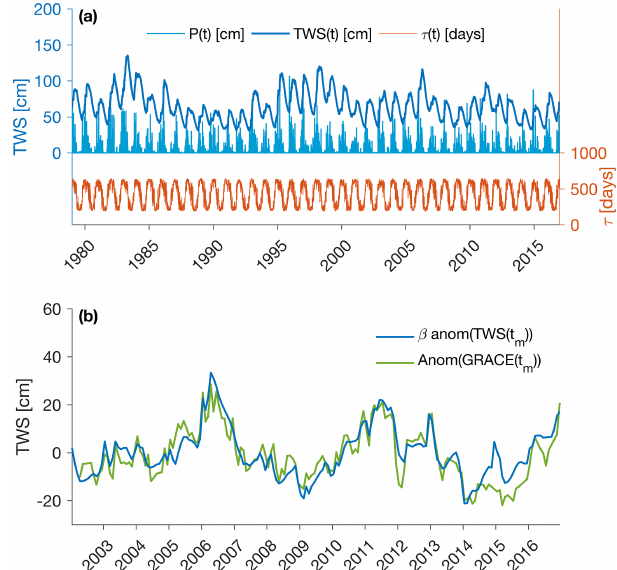
Figure 1. Illustration of the GRACE reconstruction at one given 3 ◦ × 3 ◦ mascon (located in California). (a) Input daily precipita- tion time series P ( t ), temperature-dependent residence time τ ( t ), and the resulting daily TWS time series TWS( t ). (b) Agreement between GRACE and GRACE-REC after subtracting the seasonal cycle and long-term trend (zoomed over the period